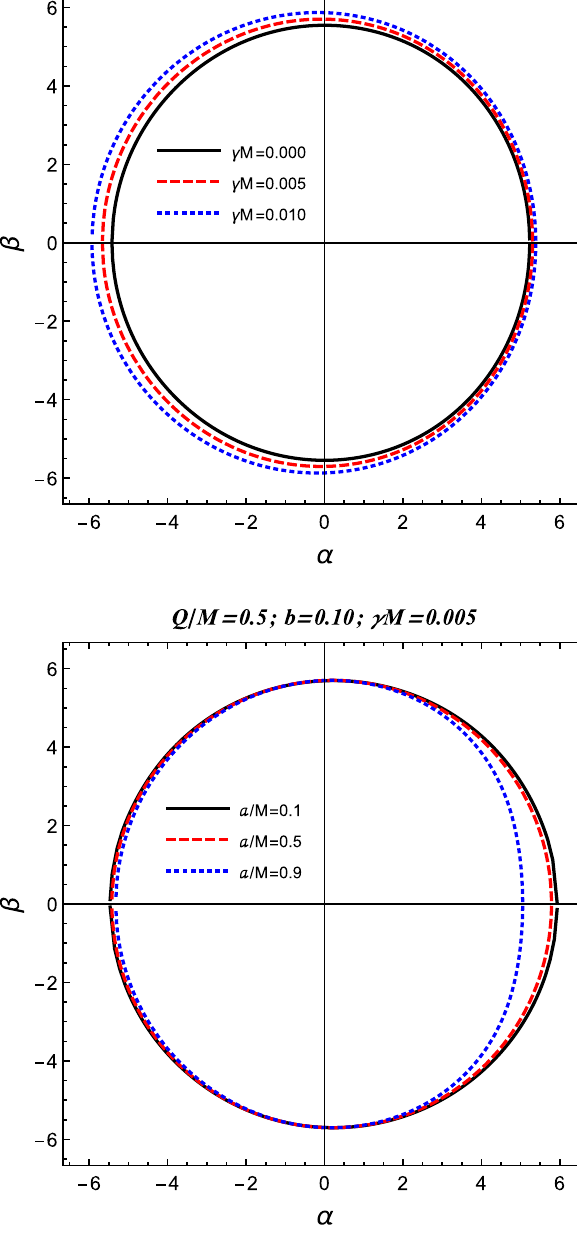
parameters have an influence on the shape and size of the shadow cast by the KNKL black hole. Here we denote the radius of the circular shadow of